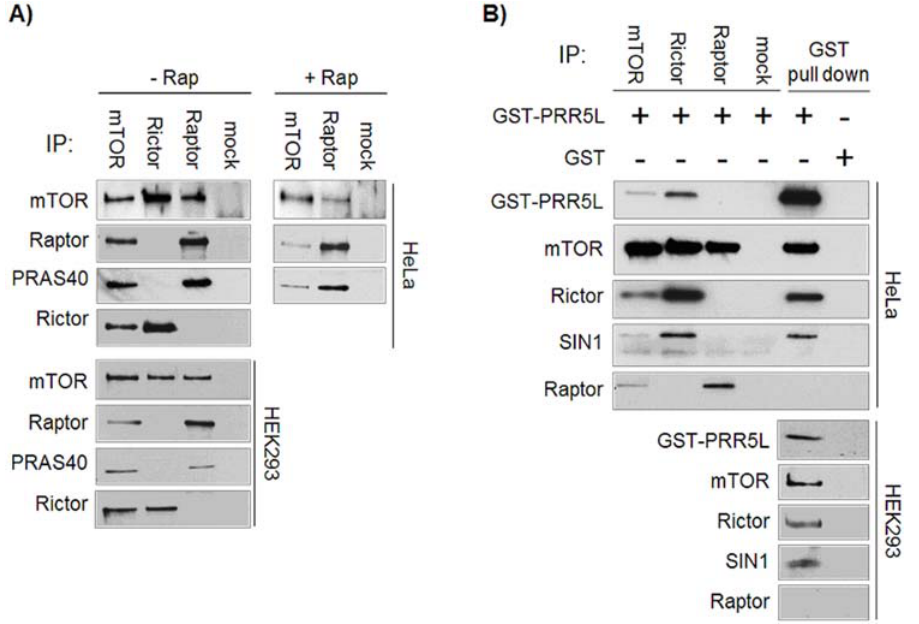
Figure 1. Confirmation of PRAS40 and PRR5L binding to mTOR. A. PRAS40 is associated specifically with mTORC1. mTOR, Rictor, Raptor and mock IPs were performed with HeLa and HEK293 extracts and analyzed by immunoblotting. PRAS40 was found specifically in mTOR and Raptor IPs. 1 h rapamycin treatment of cells dissociated a Raptor-PRAS40 subcomplex from mTOR. B. PRR5L is associated specifically with mTORC2. HeLa or HEK293 cells were transfected with GST-PRR5L or the empty plasmid. mTOR, Rictor, Raptor and mock IPs and GST pull downs were analyzed by immunoblotting. GST-PRR5L is detected specifically in mTOR and Rictor IPs. mTOR, Rictor and SIN1, but not Raptor, are detected specifically in GST- PRR5L pull